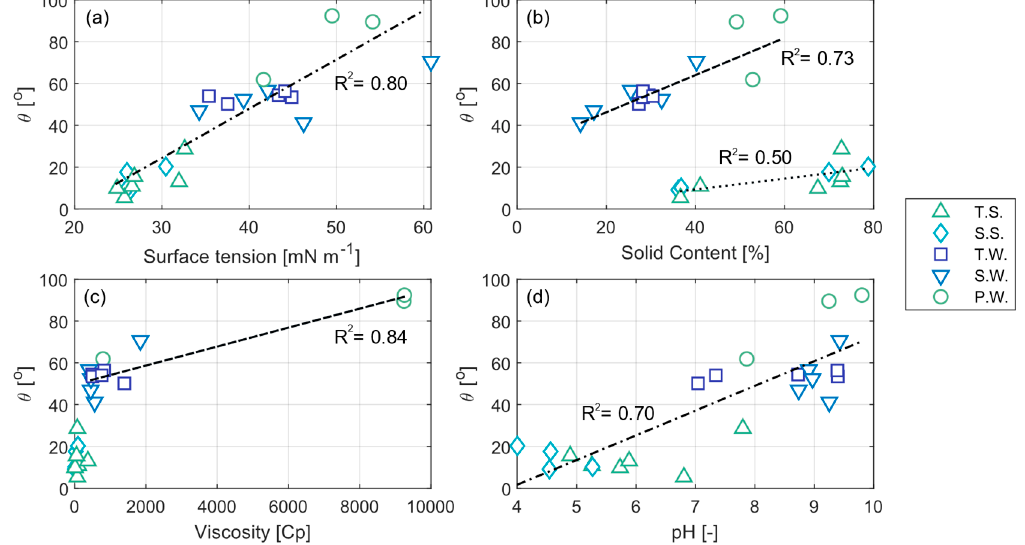
Figure 14. Contact angle dependency on various fluid properties: ( a ) surface tension, ( b ) solid content, ( c ) viscosity, and ( d ) pH. Dashed lines (---) are water-based coating trends, dotted lines ( ⋯ ) are for solvent-based coatings, and alternating dash–dot lines ( ∙ (cid:3398) ∙ ) are for combined water and solvent-based trends.